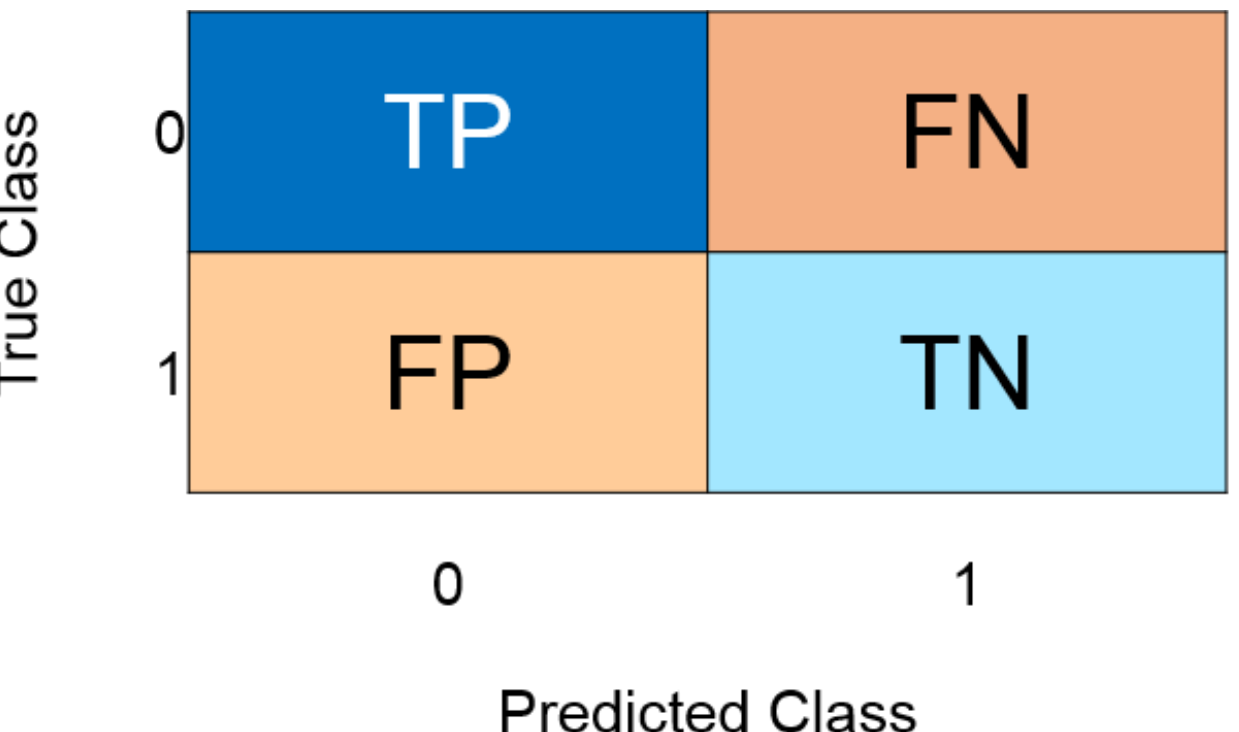
Figure 8. Confusion matrix to visualize the performance of a supervised learning algorithm.